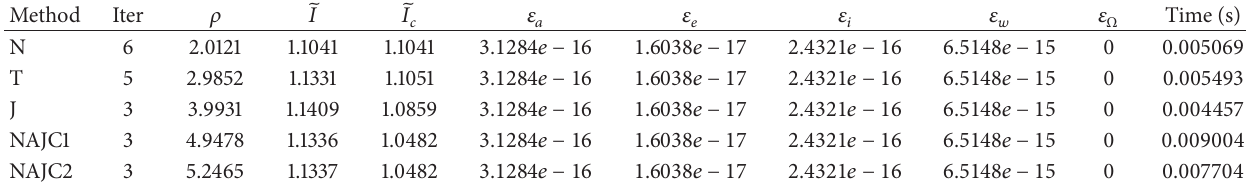
Table 4: Results of tundra Orbit.